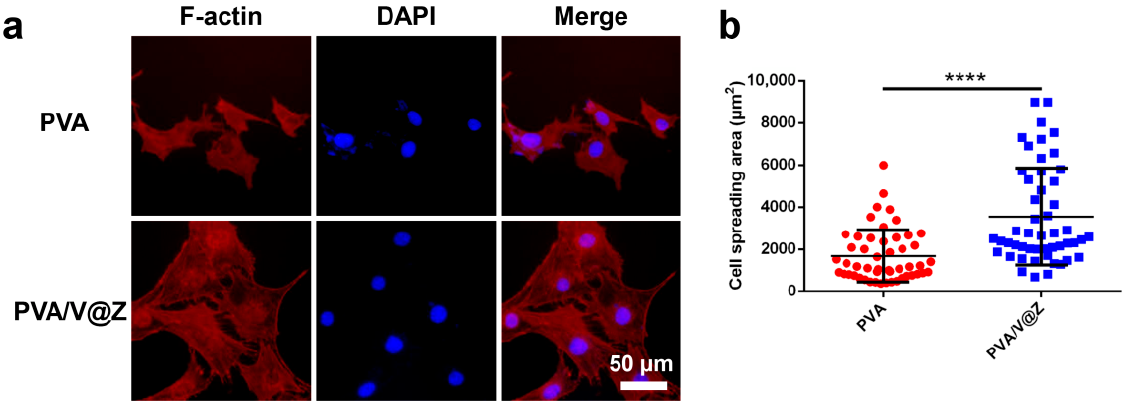
Figure 8. ( a ) Images of MC3T3-E1 cells stained with F-actin (red) and nucleus (blue) after being cultured on different fibrous membranes for 72 h: TRITC phalloidin: F-actin; DAPI: nuclei; Merge: merged channel of F-actin and DAPI; ( b ) Corresponding statistical results of cell spreading area. Mean values and standard deviations of 50 cells are presented. (**** p < 0.0001)